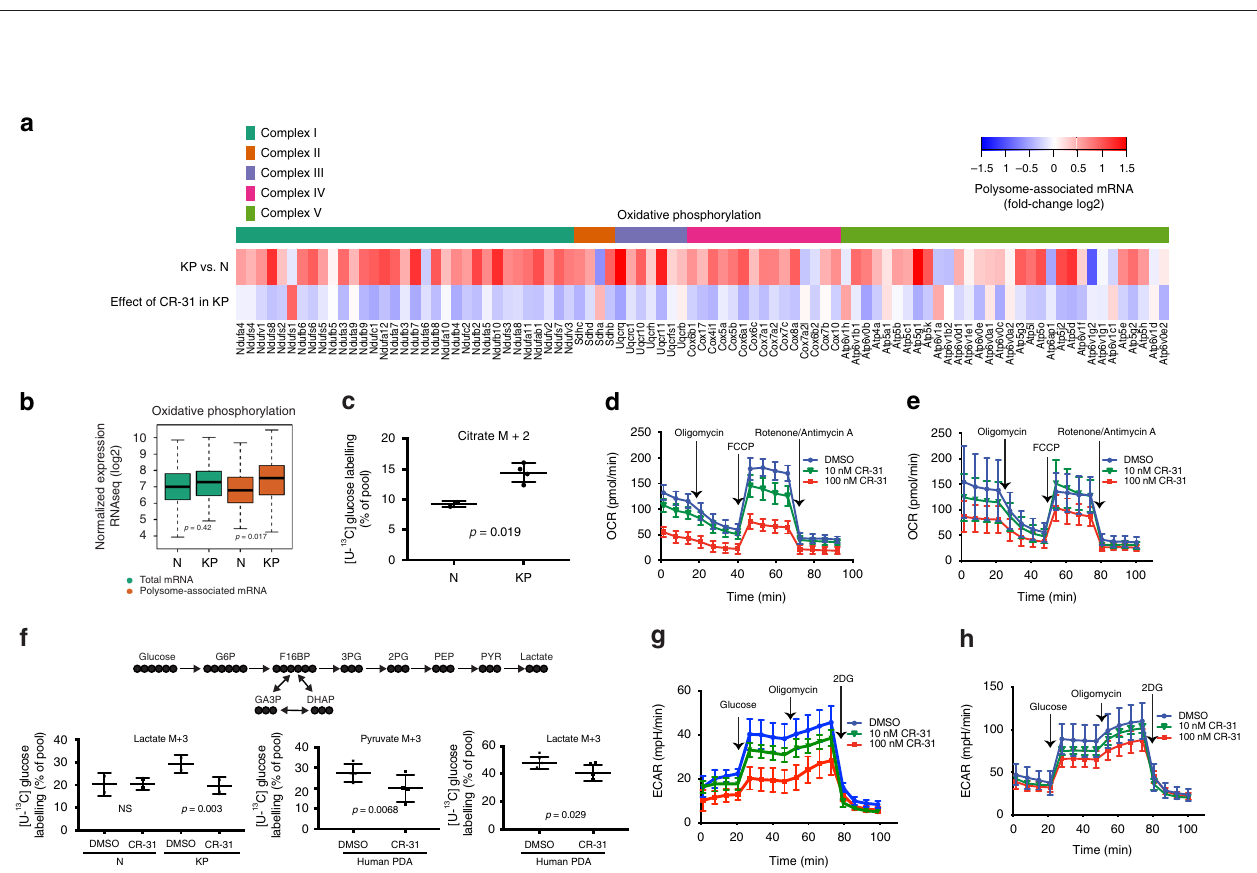
Fig. 3 CR-31 translationally targets glutathione metabolism in PDA. a Heatmap of glutathione metabolism pathway proteins (KEGG database) showing fold-changes of polysome-associated mRNA. b Relative levels of NADPH normalized to viability based on CellTitre-Glo (CTG) assay (left) and ratio of NADP + to NADPH (right) in organoids and patient-derived PDA lines upon treatment with vehicle (DMSO) or 100 nM CR-31 for 16 h. Data are mean + / – S.D. Student ’ s t -test, n = 4 (organoids), n = 5 (patient-derived lines). NS = not signi fi cant. c Relative levels of glutathione in patient-derived PDA lines upon treatment with vehicle or CR-31 for 24 h. Data are mean + / – S.D., Student ’ s t -test. n = 5, NS = not signi fi cant. * p < 0.05 compared to DMSO treatment. d Ratio of GSH to GSSG in patient-derived PDA lines upon treatment with vehicle or the indicated concentrations of CR-31 for 24 h. Data are mean + / – S.D., Student ’ s t -test, n = 5. * p < 0.05 compared to DMSO treatment. e ROS levels in KP organoids upon treatment with vehicle or 10 nM CR-31 for 16 h. Data are representative from three biological replicates. f NRF2 protein levels in KP organoids treated with CR-31 for 16 h. Actin, loading control. Representative image from 3 biological replicates. g mRNA expression of NRF2 target genes in 3 patient-derived PDA lines upon treatment with CR-31 for 5 or 24 h. Data are mean + / – S.D. Each data point plotted is average from every biological replicate. h Cell viability of KP and Nrf2 -de fi cient KP (KPn) organoids upon a 72 h treatment with increasing concentrations of CR-31. Dotted lines indicate 95% con fi dence intervals, n = 5. i Cell viability of patient- derived PDA lines upon treatment with increasing concentrations of CR-31 in the presence or absence of 100 μ M buthionine sulfoximine (BSO) for 72 h. Data are mean + / – S.D., n = 5. j Cell viability of primary murine PDA lines upon treatment with increasing concentrations of CR-31 in the presence or absence of 1 mM of the ROS scavenger N-acetylcysteine (NAC) for 72 h. Data are mean + / – S.D., n = 3. Source data are provided as a Source Data fi le